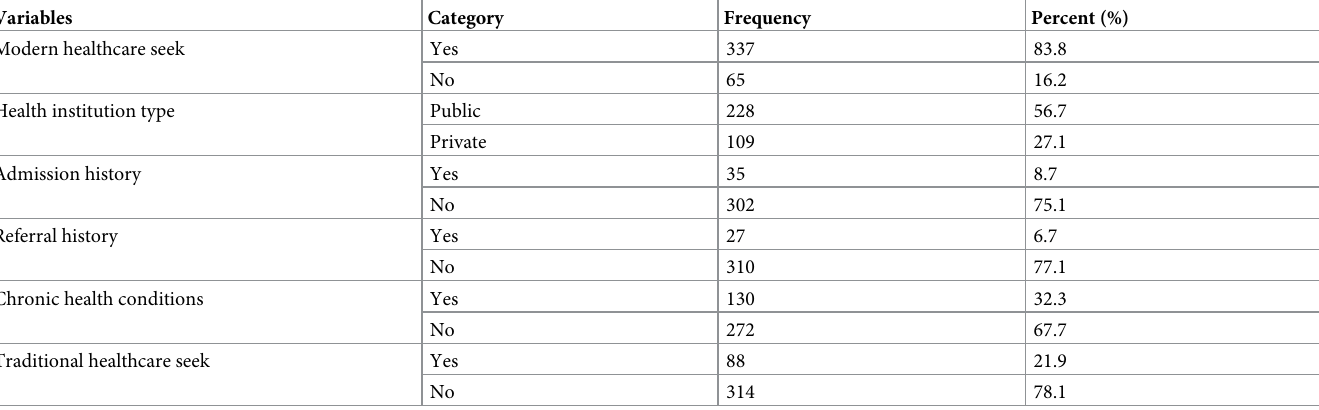
Table 3. Health and health related characteristics of households, Debre Tabor town, Ethiopia,